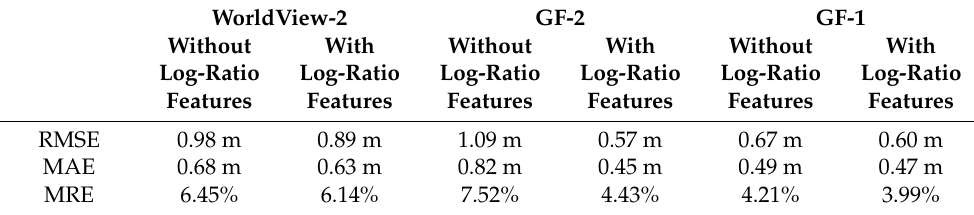
Table 6. Accuracy of the reconstructed signals in the Dongdao Island study